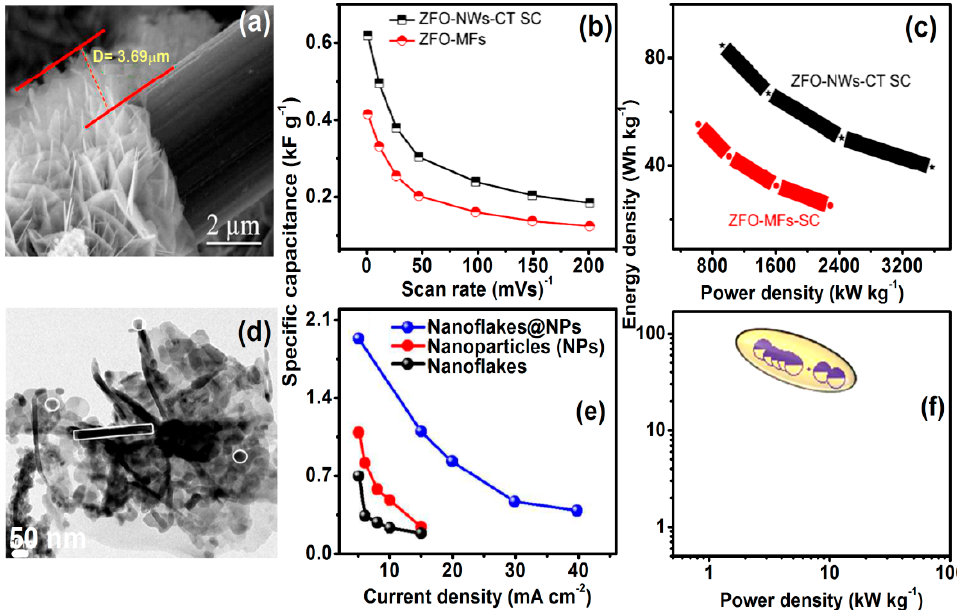
Figure 16. Hydrothermal method: ( a ) SEM images of ZFO precursor nanowall arrays on CT fibres, ( b ) specific capacitances as a function of scan rate, and ( c ) comparative Ragone plots (Reproduced with permission from [98]. Copyright Elsevier, 2019). In-situ bio-mediated green rotational chemical bath deposition: ( d ) TEM of ZnFe 2 O 4 nano-flakes@ZnFe 2 O 4 /C nanoparticle thin film heterostructure, ( e ) plot of specific capacitance (F g − 1 ) vs. current density (mA cm − 2 ) and ( f ) Ragone plot (Reproduced with permission from [99]. Copyright American Chemical Society, 2017).